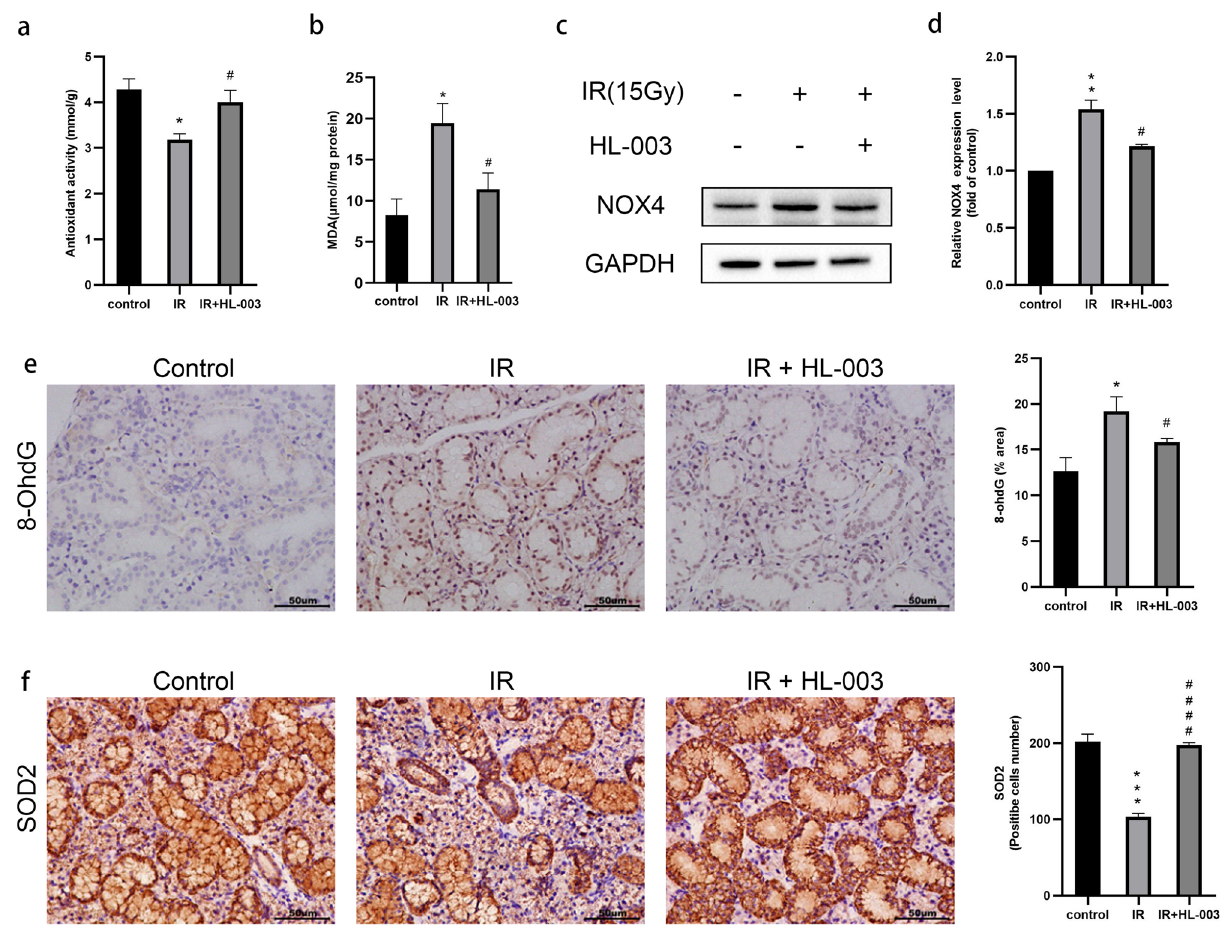
Figure 3. HL-003 reduces oxidative stress. ( a ) Total antioxidant capacity levels were determined. ( b ) The concentration of MDA was determined. ( c,d ) Western blot analysis of NOX4. Relative quantification of the expression of NOX4 is shown. ( e,f ) Representative immunohistochemical images of 8-OHdG and SOD2. Scale bars represent 50 μm. Relative quantitative analysis is shown. Each bar shows the mean ± SEM; *p < 0.05, **p < 0.01, ***p < 0.001, compared with the control group; # p < 0.05, #### p < 0.0001, compared with the IR group (n = 6 per group).